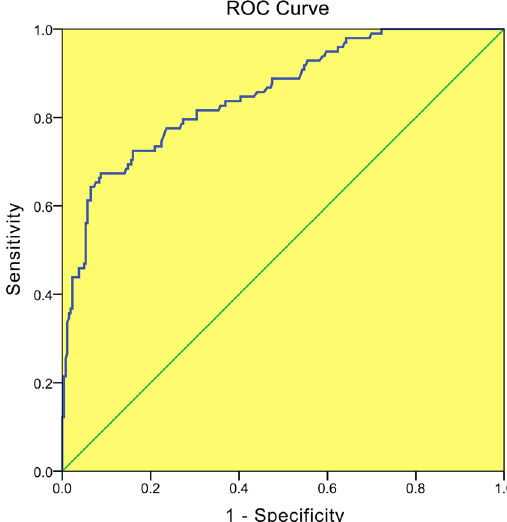
Figure 2. The operating characteristic (ROC) curve of SWS max .